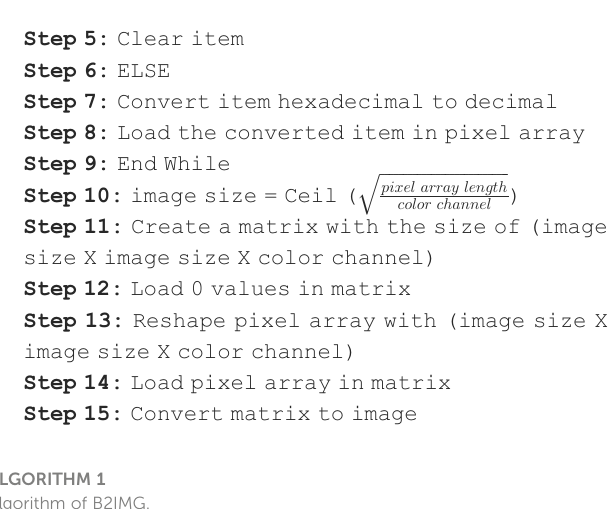
ALGORITHM 1 Algorithm of B2IMG.